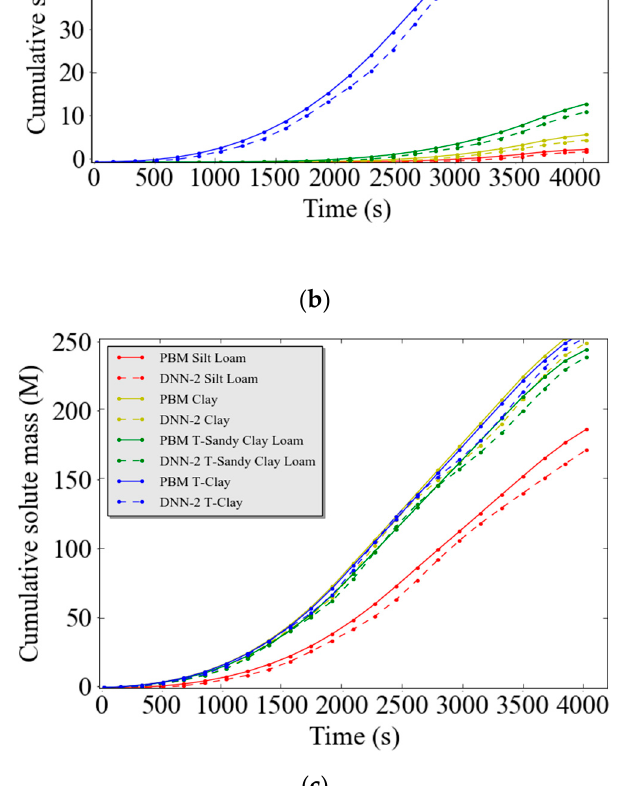
Figure 9. Comparison of the cumulative solute mass (in grams, M) calculated by the PBM and the DNN-2 model for the near equilibrium training data set (( a ) overall, ( b ) different initial water contents, ( c ) different textures)).